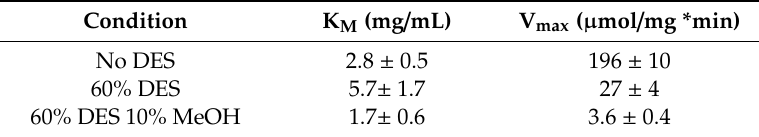
Table 1. Kinetic constants of amylase Amy A.